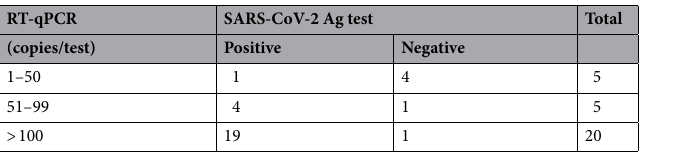
Table 5. Relationship between the SARS-CoV-2 viral loads and COI in the assay kit using commercially available samples. COI cut-off-index, SARS-CoV-2 severe acute respiratory syndrome coronavirus 2, RT-qPCR reverse transcription quantitative polymerase chain reaction, Ag